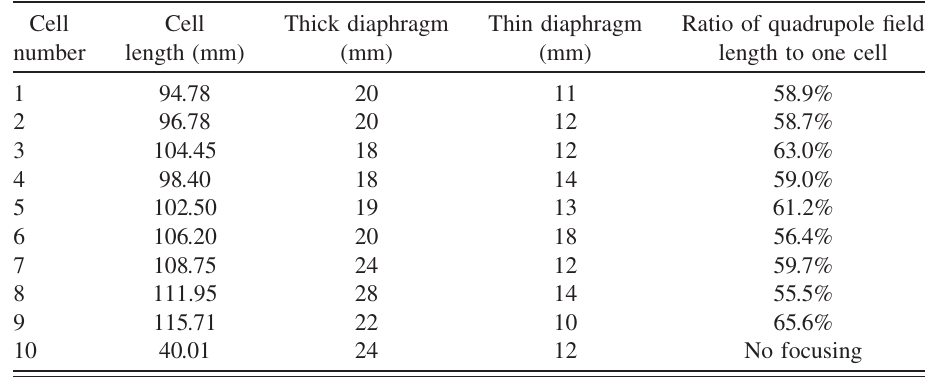
TABLE VI. Diaphragm parameters of the